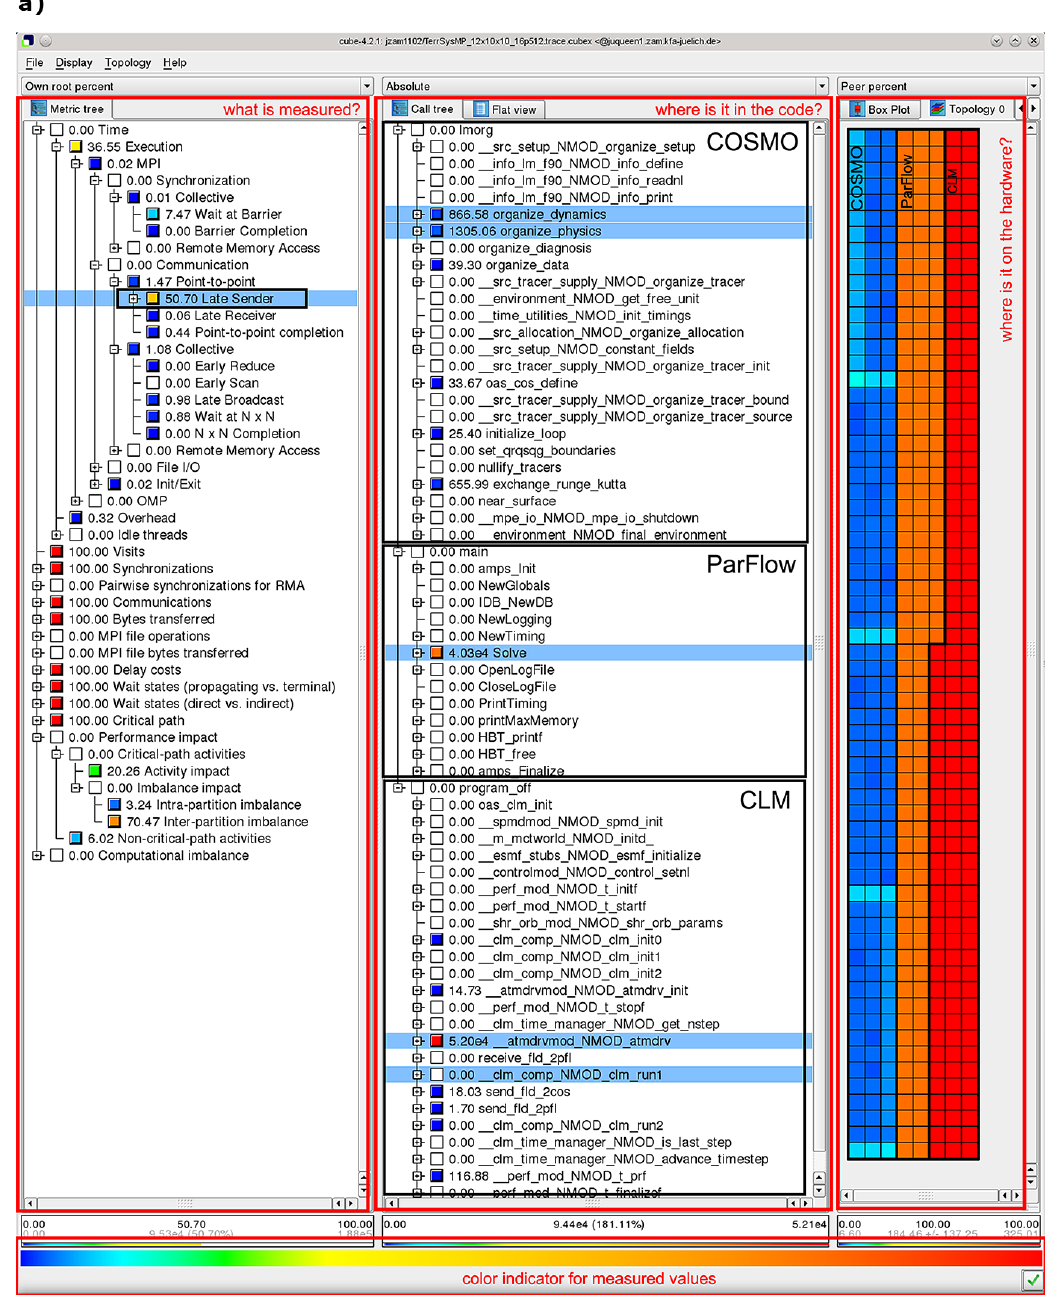
Figure 3a. CUBE screenshots of the fully coupled TerrSysMP after 6h simulation time. Each component model is naively distributed to one-third of the resources (processor distribution: 192 COSMO, 160 ParFlow, 160